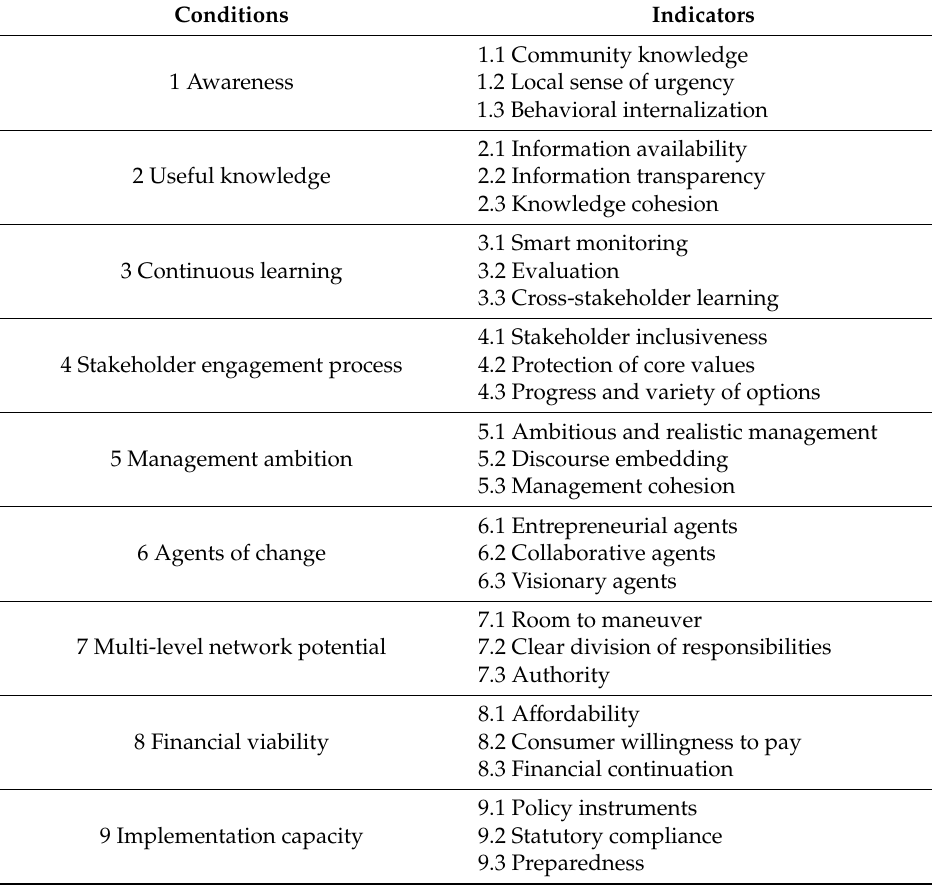
Table 4. Indicators of the Governance Capacity Framework